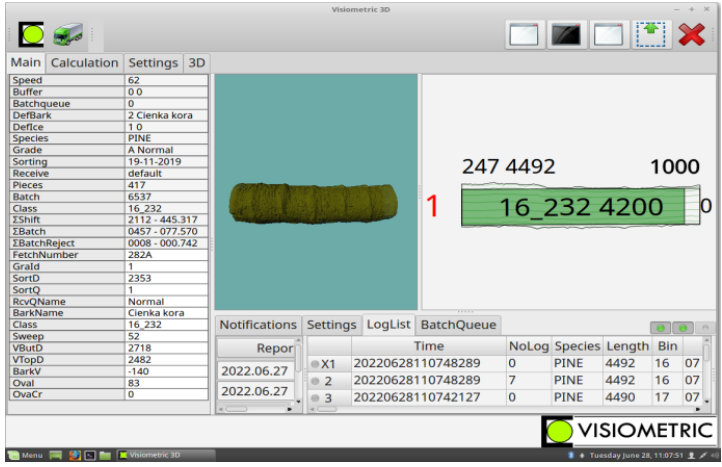
Figure 4. Example of wood measurement image from laser scanning on the log sorting line.